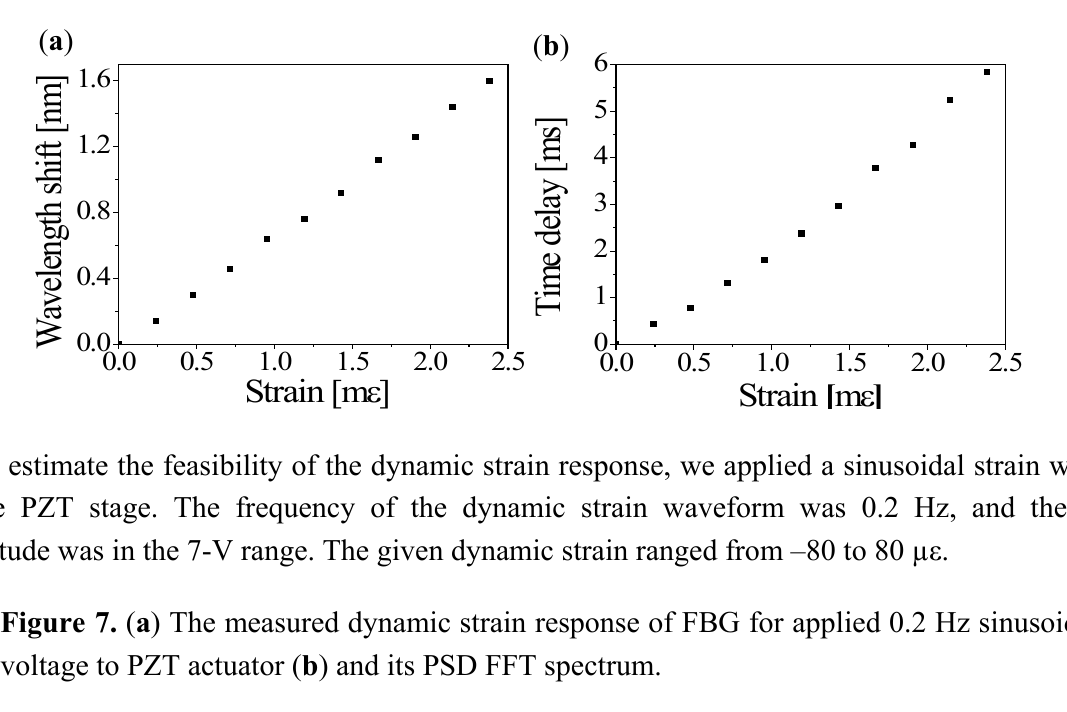
Figure 6. The static strain response of FBG in ( a ) the wavelength domain, and ( b ) the time domain.